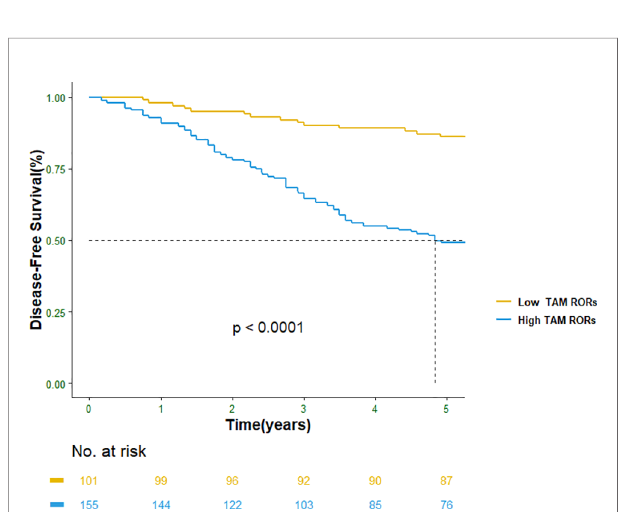
FIGURE 3 | Disease-free survival (DFS) in TAM RORs. TAM RORs, tamoxifen risk-of-recurrence score.